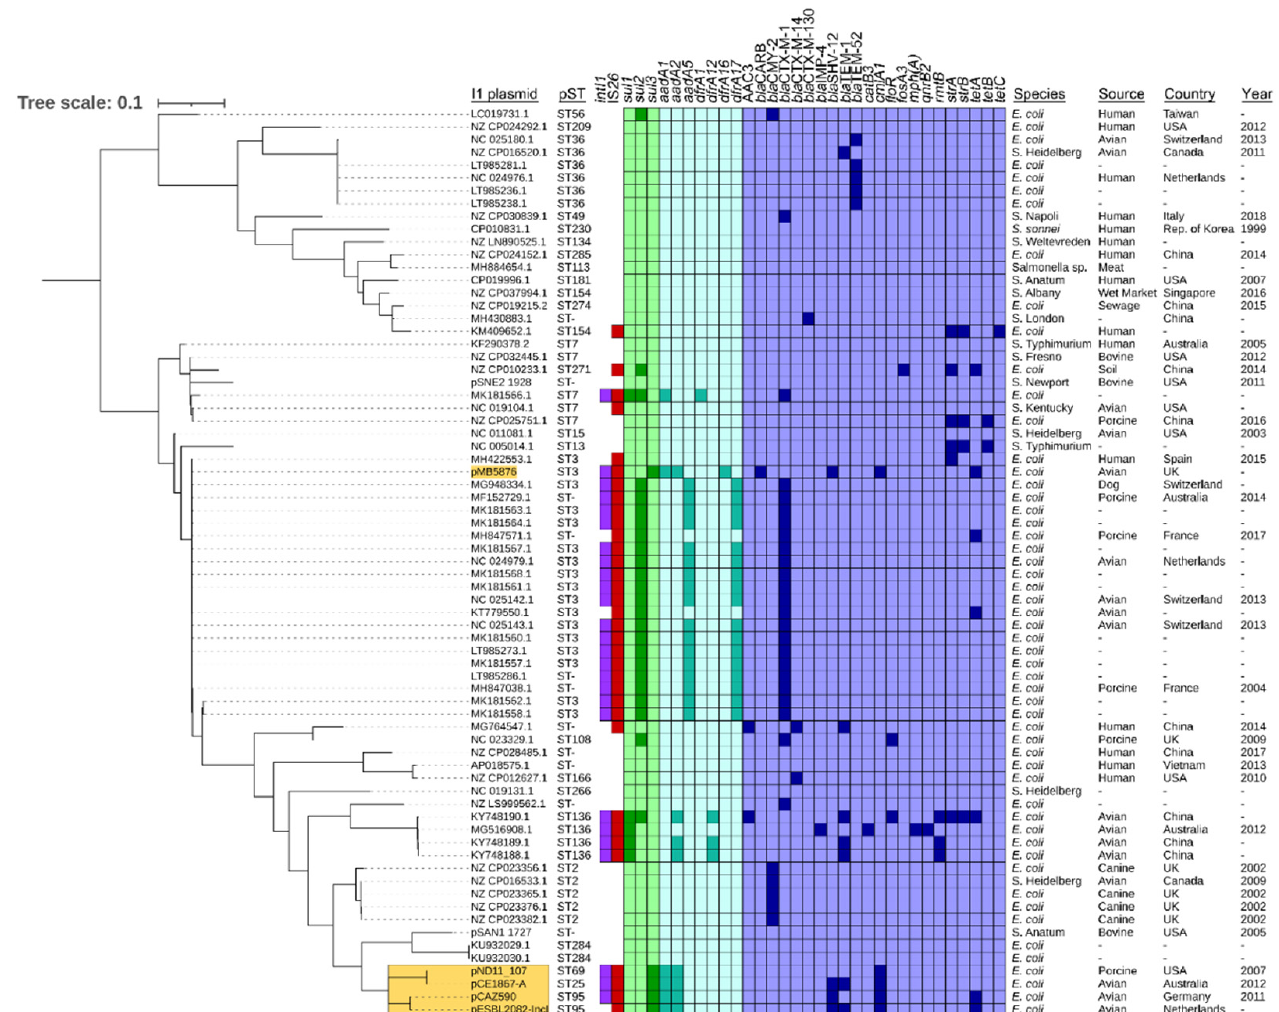
Figure 2. Plasmid SNV phylogeny (mid-point rooted) of I1 plasmids ( n = 71). Data presented include plasmid multi-locus sequence typing data, presence of intI1 and IS 26 , and ARGs, followed by available plasmid metadata (bacterial host species, isolation source, country/region, and year of isolation). Darker colors indicate a positive hit for ARGs. Plasmids relevant to this study are highlighted yellow. Tree scale is presented in SNVs per site.